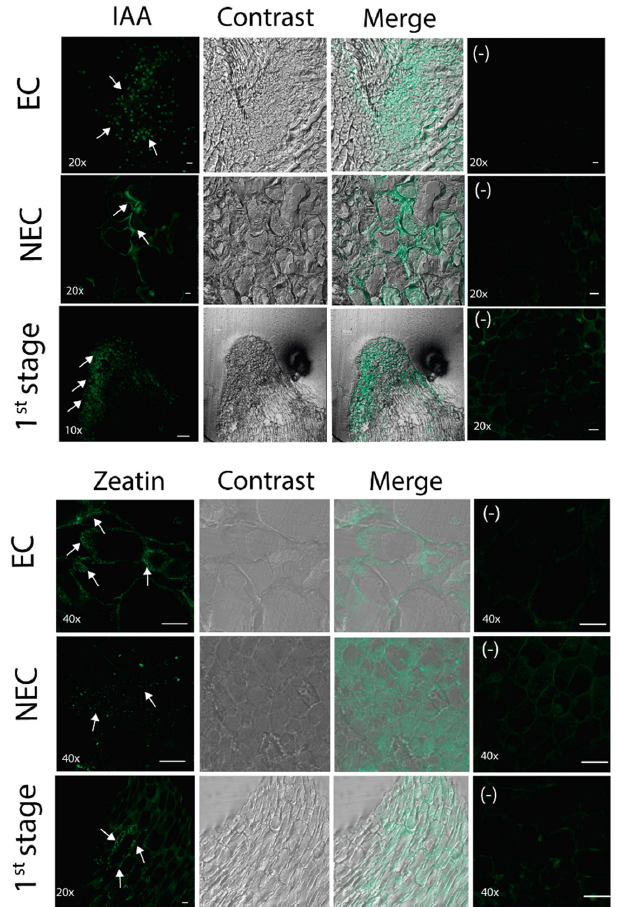
Figure 4. Immunolocalization of auxin and cytokinin in different tissues. Sections from NEC, EC and the 1st regeneration stage were analyzed using anti-indole-3 acetic acid (IAA) and anti-trans zeatin antibodies. Fluorescence, bright field and merged images are shown for each tissue. Microscope magnification and negative control (samples incubated without primary antibody) are represented in the images. The arrows indicate fluorescence signal. In the NEC, IAA exhibited more intense signal at cell periphery, while in the EC, the auxin was detected as interspersed spots. During the 1st stage of regeneration, the auxin signal was detected at the tip of the regenerative spot. The cytokinin immunolocalization was observed only for EC tissue, as patches surrounding cells, and at the 1st stage of development over the middle portion of a regeneration spot. Bar = 20 µ m, except in the auxin immunolocalization from 1st stage, where bar = 100 µ